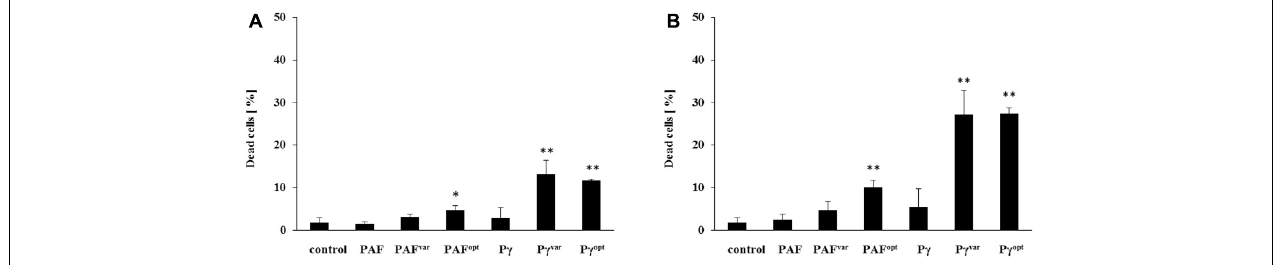
FIGURE 3 | Early-stage candidacidal activities of AMPs. C. albicans was exposed for 10 min to (A) 1 × MIC and (B) 2 × MIC of AMPs and analyzed with dead-cell staining by FACS. Values represent mean ± SD; ∗ P ≤ 0.05 and ∗∗ P ≤ 0.005.